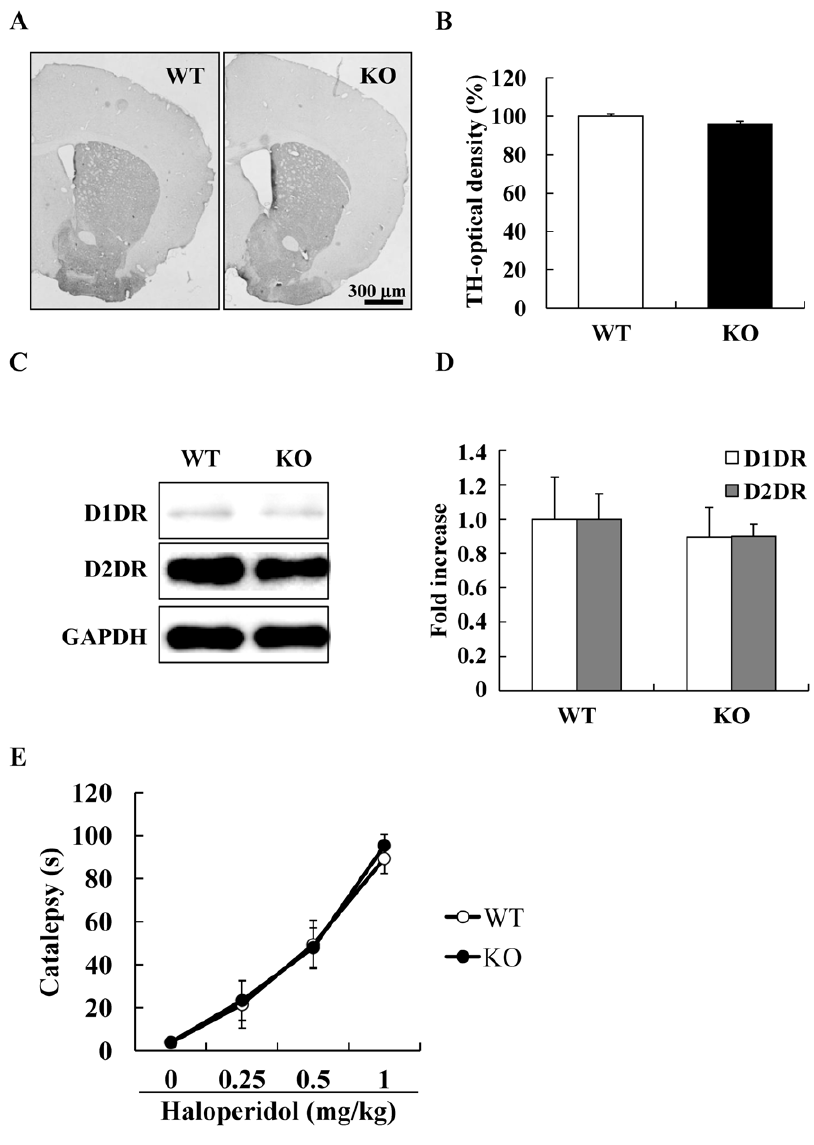
Figure 4. Dopaminergic systems in the striatum of the DGK b KO mice. (A) Representative photograph of the coronal sections of the striatum immunostained for tyrosine hydroxylase (TH) of WT and DGK b KO mice. Scale bar shows 300 m m. (B) Optical density of TH-positive fibers in the striatum of WT and DGK b KO mice. Values are expressed as the mean 6 S.E.M. (n=3). (C) Representative immunoblots showing the expression levels of D1 dopamine receptor (D1DR) and D2 dopamine receptor (D2DR) in the striatum of WT and DGK b KO mice. (D) Protein levels of D1DR and D2DR are quantified relative to the GAPDH levels. Values are expressed as the mean 6 S.E.M. (n=6). (E) The retention time of haloperidol-induced catalepsy of WT and DGK b KO mice. Values are expressed as the mean 6 S.E.M. (n=6 to